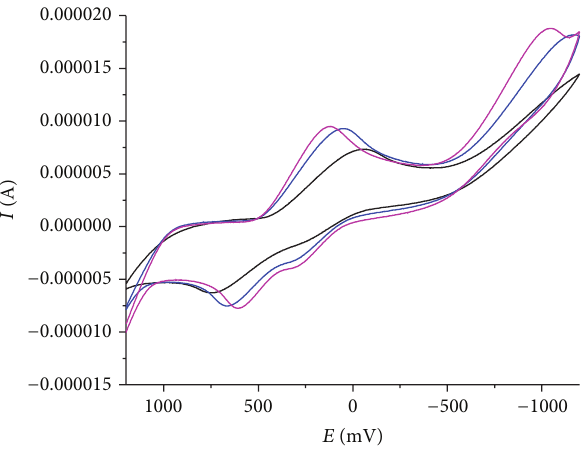
Figure 7: Cyclic voltammogram of copper(II) complex in the absence and presence of increasing amounts CT-DNA at room temperature in DMSO: buffer (1: 2) mixture (pH 7.2) (scan rate 0.1 Vs −1